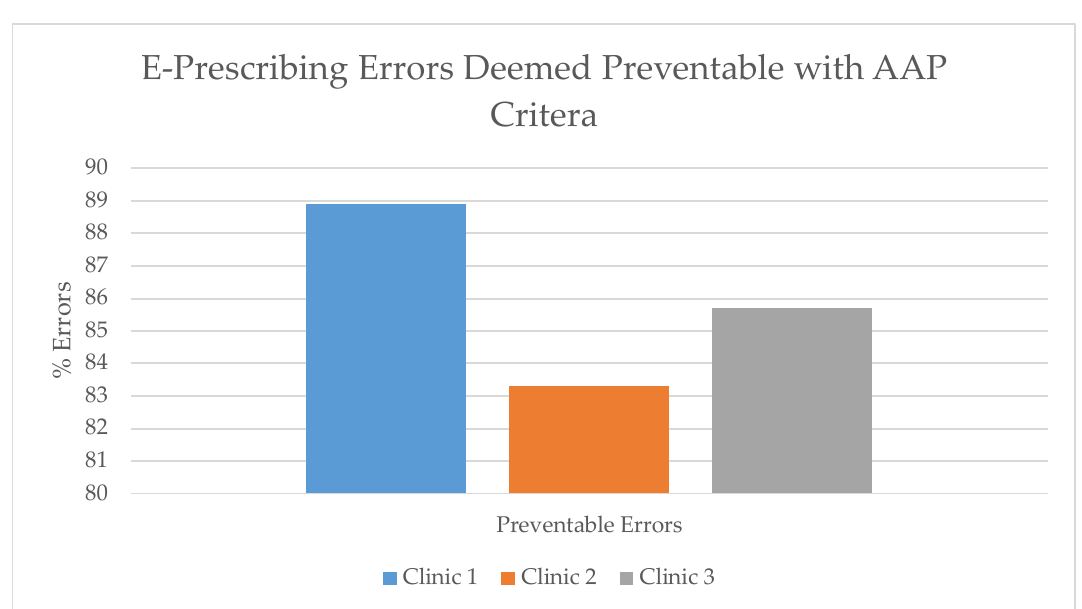
Figure 4. Clinic 3 EHR compliance with AAP recommendations. Healthcare 2019 , 7 , x FOR PEER REVIEW